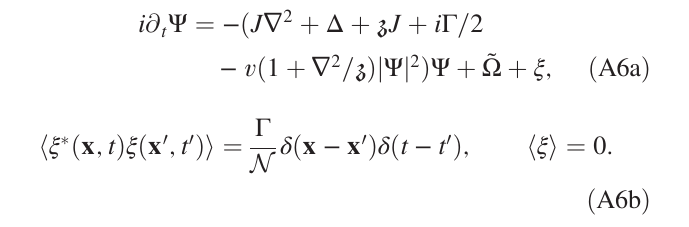
ffiffiffi p 2 Ω ψ (cid:3)